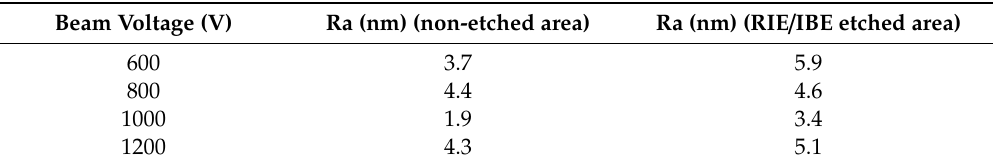
Table 2. Surface roughness Ra (Dektak measurement) after IBE as function of beam voltages.